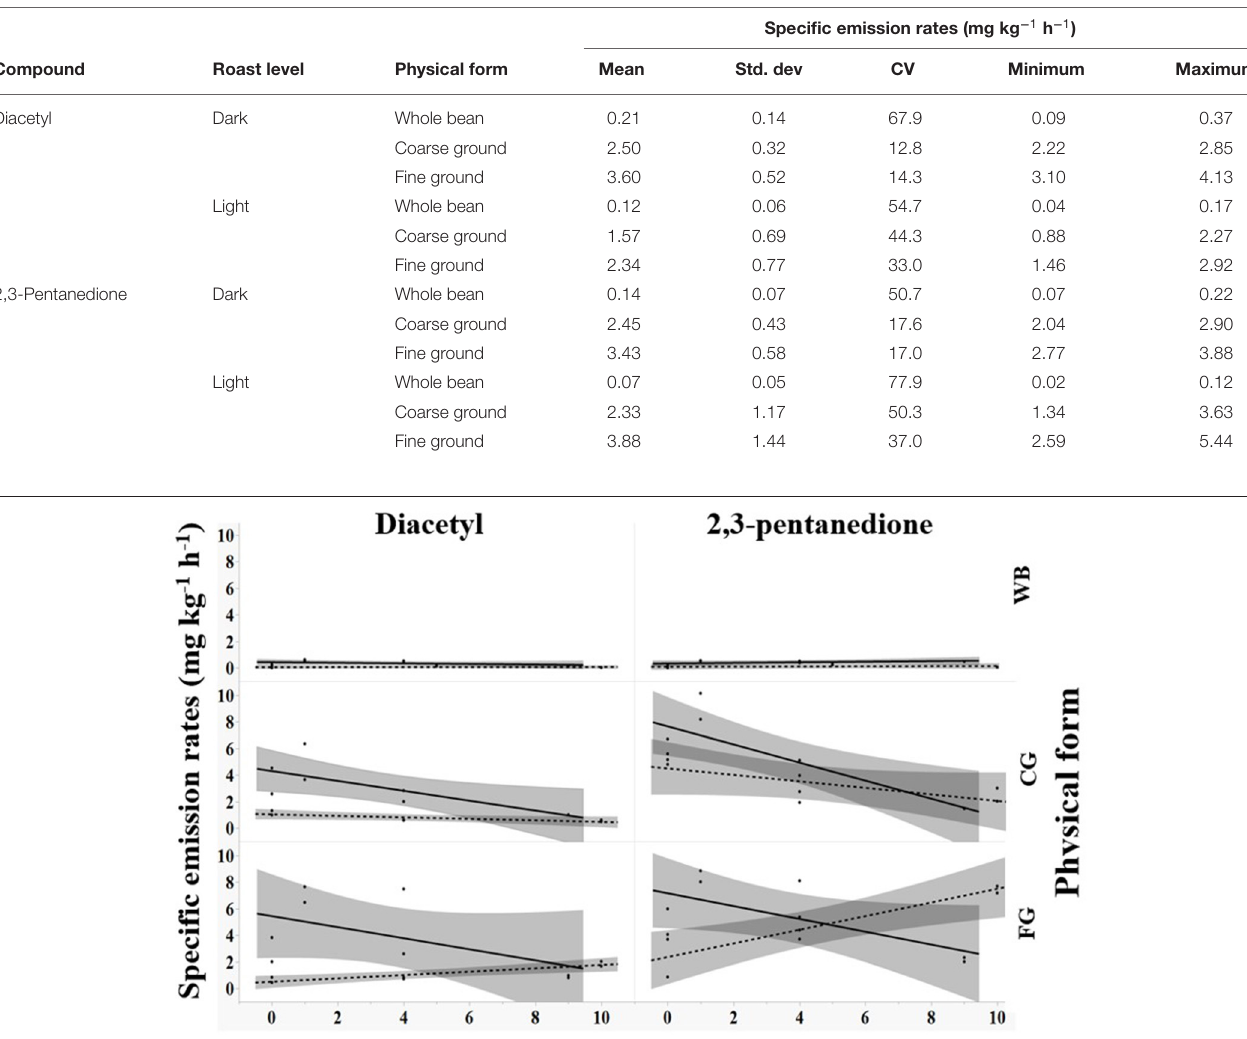
TABLE 4 | Specific emission rates ( n = 3) for diacetyl and 2,3-pentanedione for different roast levels (light, dark) and forms including whole bean, coarse ground, and fine ground.